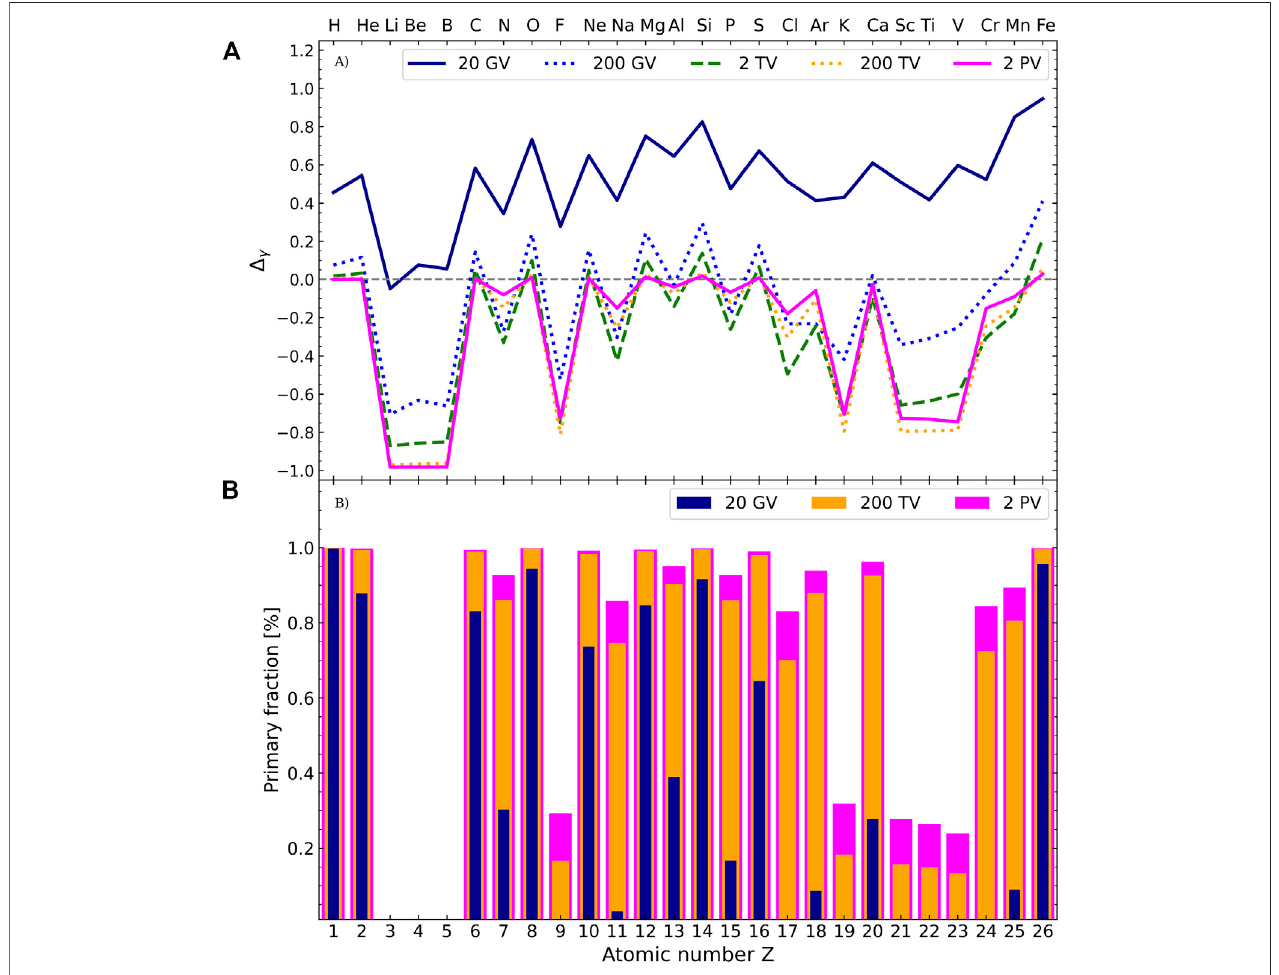
FIGURE2 | Shown for theSLIM model asa function ofthe charge Z = 1 − 26 (fromH toFe) and for various rigidities (colour-coded with different linestyles) are: (A) Δ γ (see Eq. 6 ),the “ normalised ” difference betweenthe fl ux and the “ source +diffusion ” logarithmicslopes; (B) primary fraction (relative tothetotal fl ux)forthe elements.